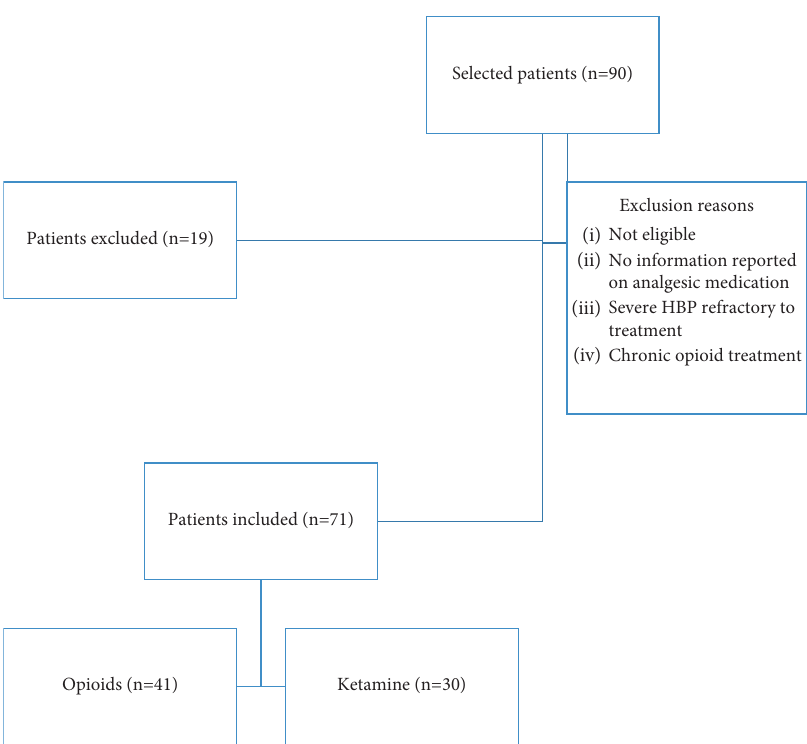
Figure 2: Flowchart showing the participant inclusion and exclusion